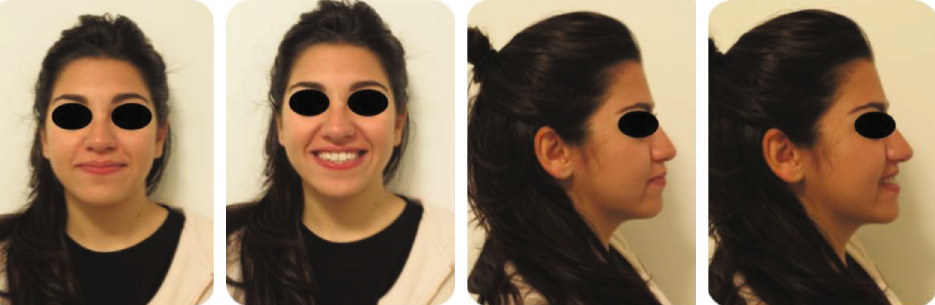
Figure 1: Pretreatment extraoral photographs.